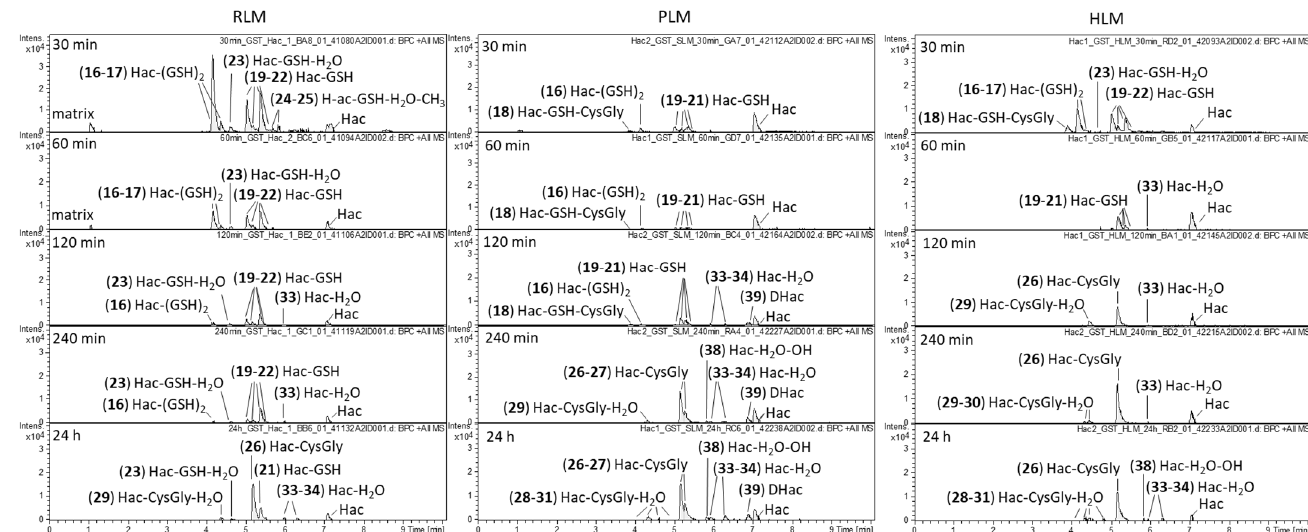
Figure 4. Difference chromatograms of Hac after incubation with RLM, PLM or HLM, NADPH regenerating system, GST and GSH for 30 min, 60 min, 120 min, 240 min and 24 h, respectively.